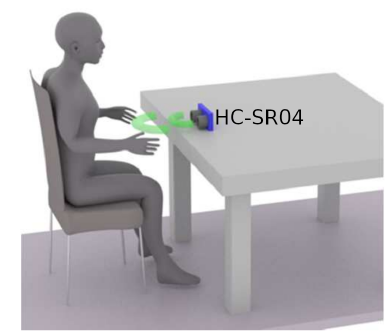
Figure 5. Sensor placement.